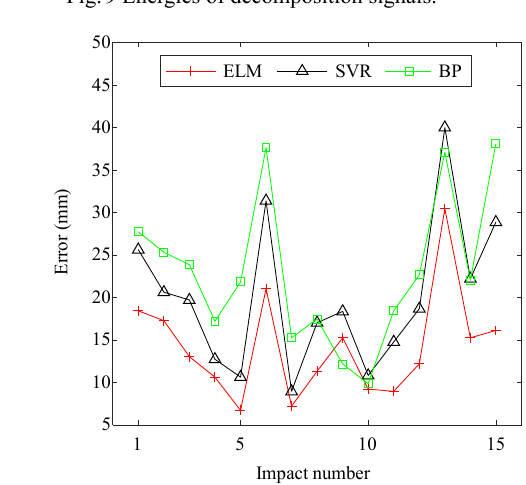
Fig. 8 Localization signals. Fig. 9 Energies of decomposition signals.